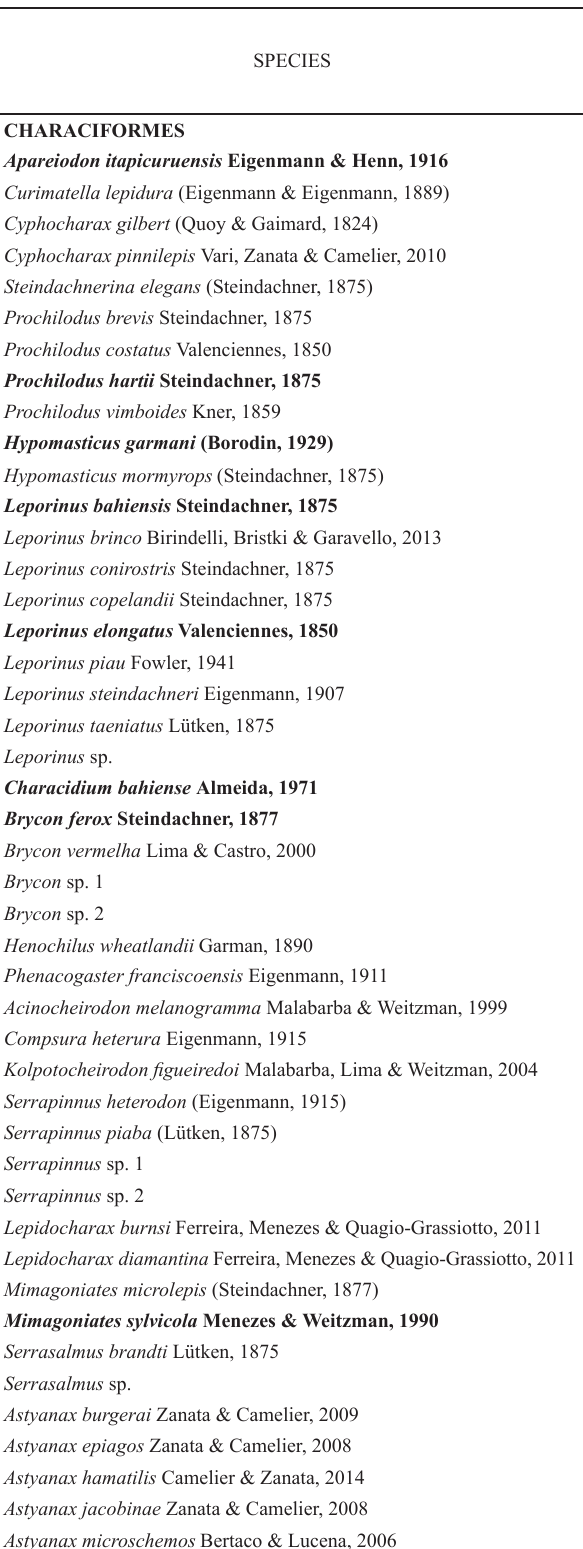
Table 1. List of species analyzed in this study and its distribution in the Northeastern Mata Atlântica freshwater ecoregion (NMAF) and adjacent ecoregions. NG = North Group, CG = Central Group, and SG = South Group. Species in bold were used to biogeographical analysis. Species occurrences are indicated by an